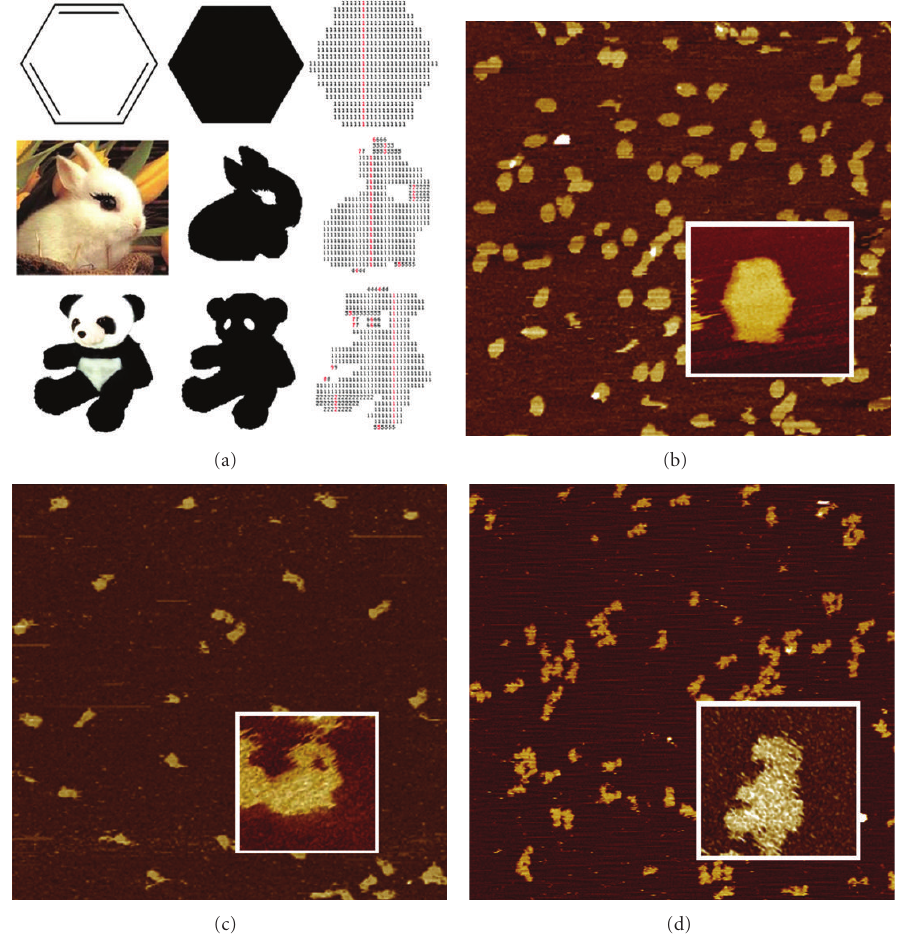
Figure 2: Examples for DNA nanostructure design. (a) left column: object picture; middle column: monochrome image, user uploaded; right column: digitized image, according to the user uploaded image. (b, c, d), wet-lab products observed by AFM. Uploaded image and digitized image are screenshots from our web server. In the digitized images, sca ff old ssDNA forms seams on the border and along the red lines. The selected shapes for validation are a hexagon, a rabbit and a panda (a). The corresponding results are (b), (c) and (d). The pathways for the sca ff old and staple DNA as well as the sequence lists for staple DNA we used for wet-lab experiments are shown in the Supplementary Materials (see Supplementary Materials available online at